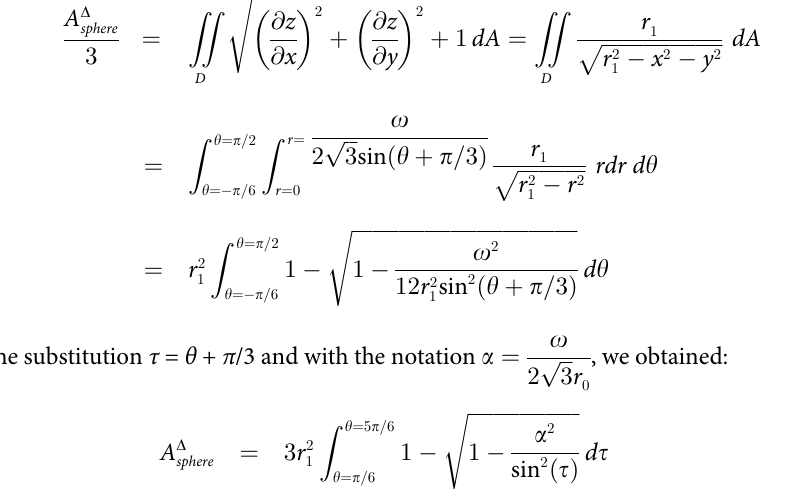
r 1 ffiffiffiffiffiffiffiffiffiffiffiffiffiffiffiffiffiffiffiffiffiffiffiffi